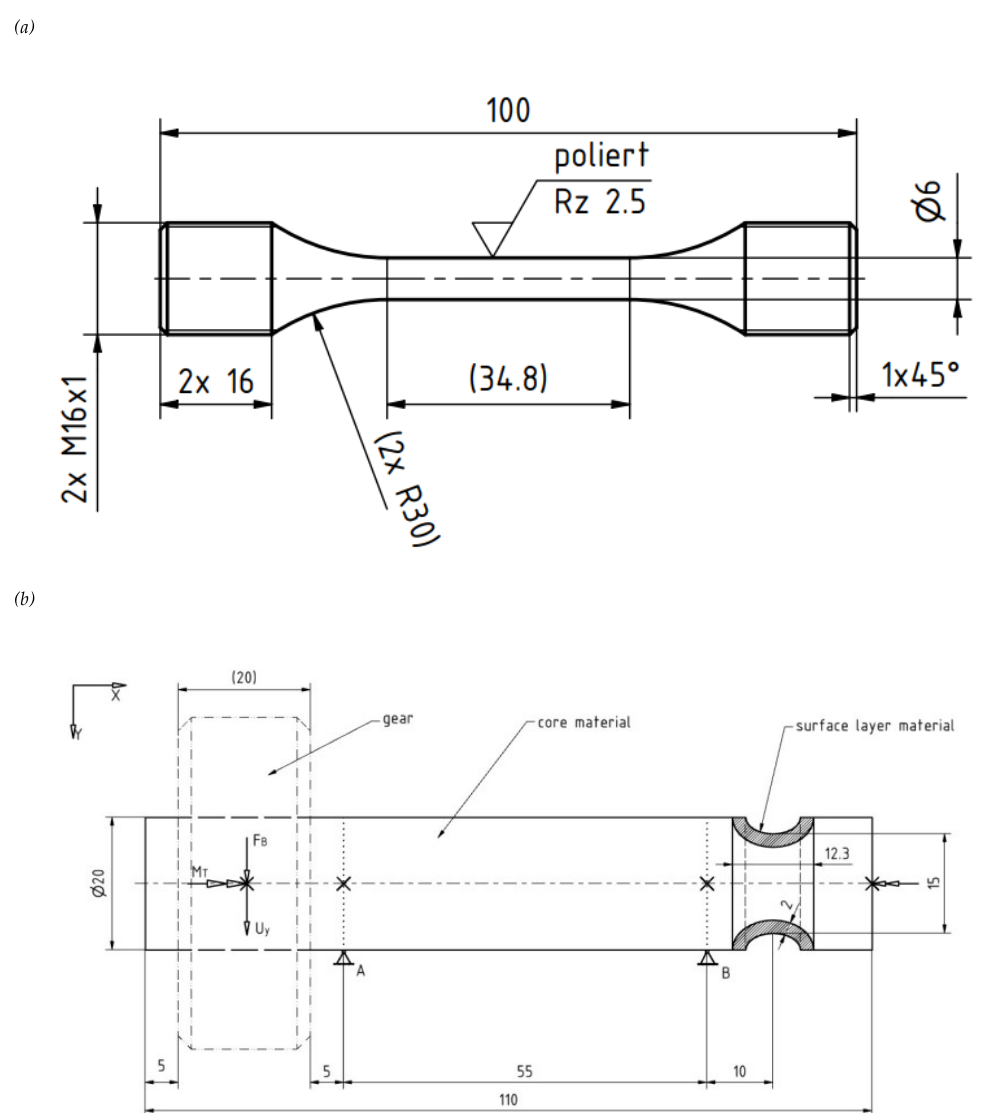
Figure 1. ( a ) Specimen geometry for the fatigue tests ( b ) Geometry and load case of the analyzed generic shaft. All dimen- sions in mm.